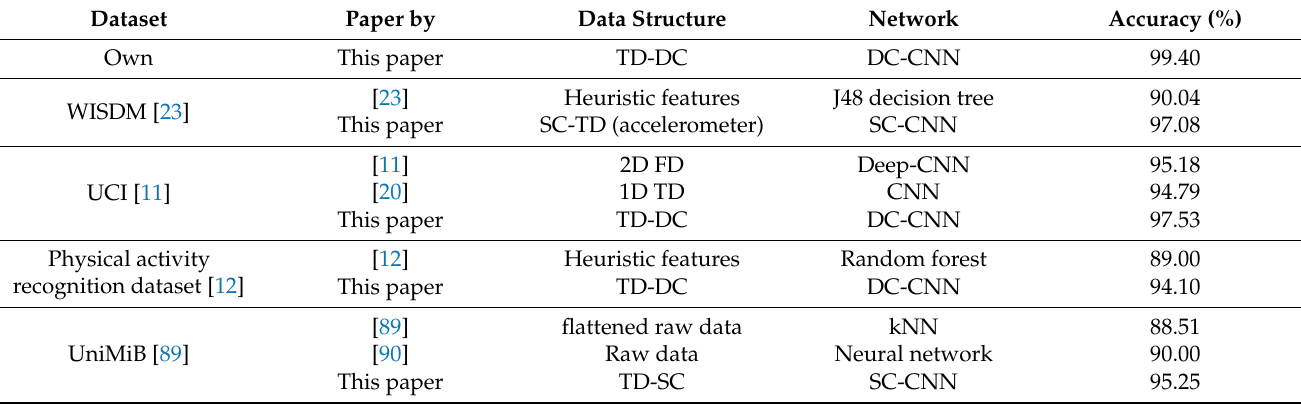
Table 4. Comparison of different models over different